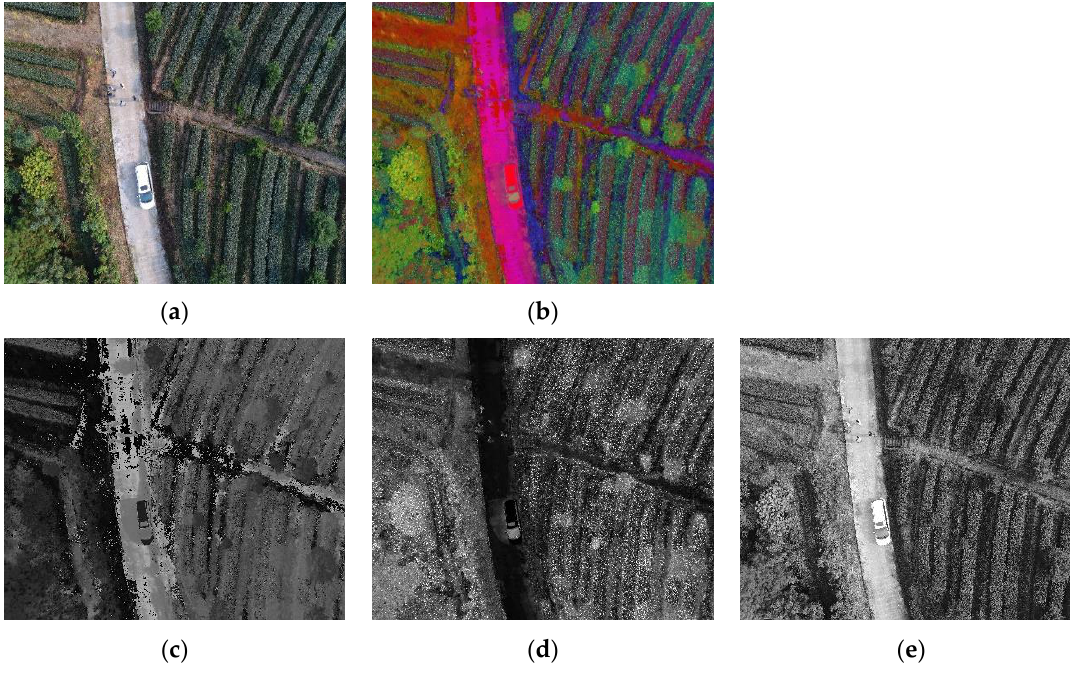
Figure 4. HSV model and components. ( a ) RGB model; ( b ) HSV model; ( c ) H component; ( d ) S component; and ( e ) V component. component; and ( e ) V